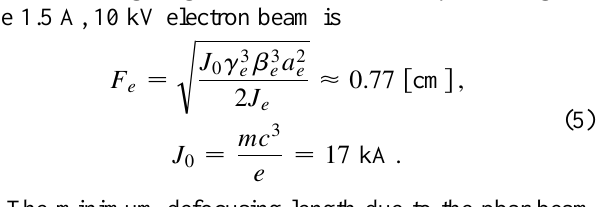
Figure 1 shows trajectories vs longitudinal coordinate (cid:122) for electrons which originally had no transverse velocities and started at radii equal to (cid:114) (cid:48) (cid:173) (cid:48)(cid:46)(cid:49) , 0.5, 0.8, and 0.9 mm in the absence of longitudinal magnetic field.